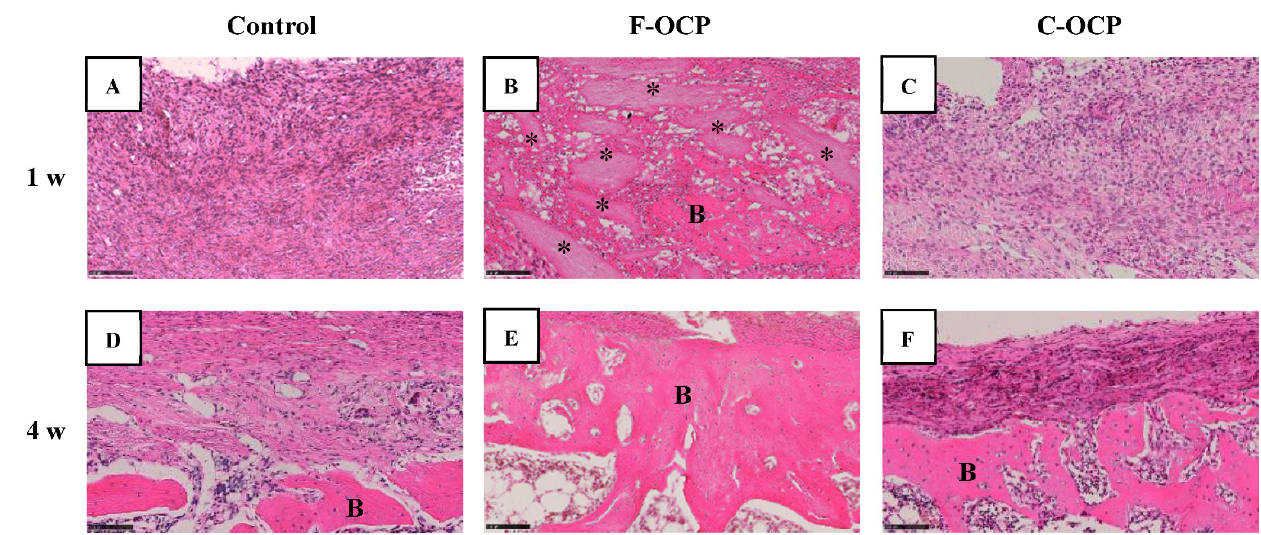
Figure 8. High-magnification images of tibia defect regions of histological sections stained with hematoxylin and eosin after treatment with no materials (control) ( A , D ), F-OCP ( B , E ) and C-OCP ( C , F ) at 1 week ( A – C ) and 4 weeks ( D – F ) post-implantation. Bars in the panels represent 100 µ m. B, newly formed bone; asterisks (*), remaining OCP granules.